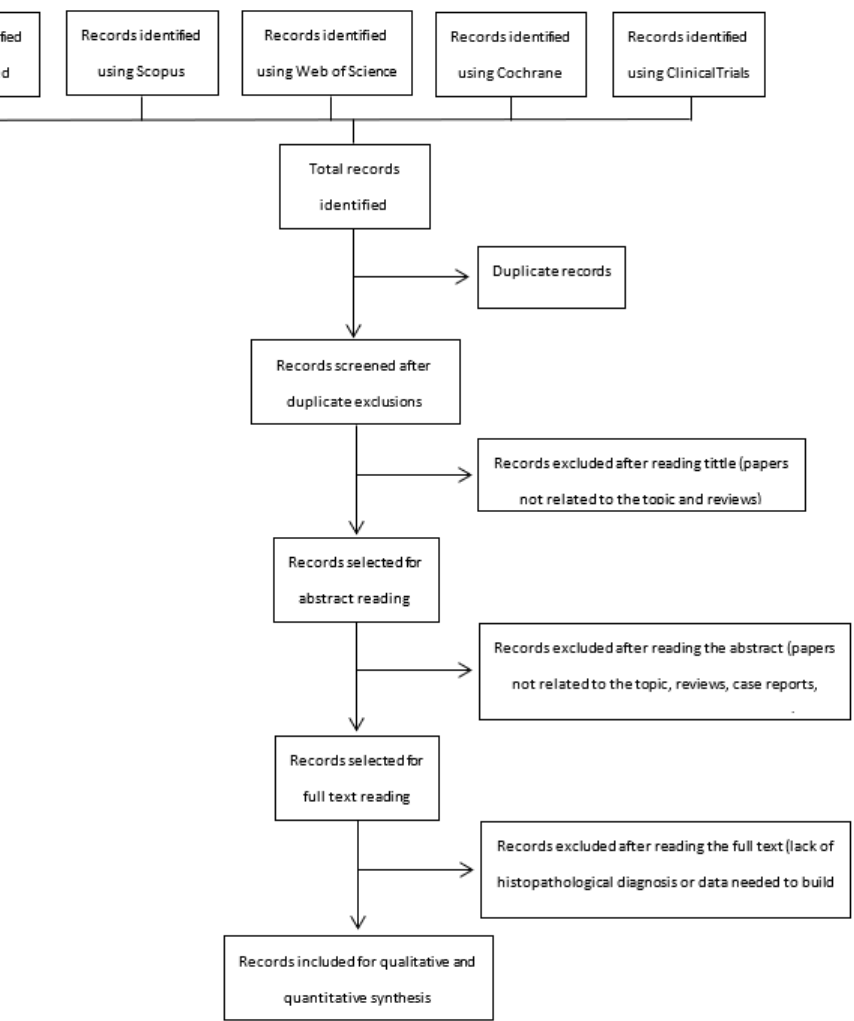
Figure 1. Flowchart summarizing the literature search indicating the exclusion process and the number of studies finally included in the current meta-analysis.